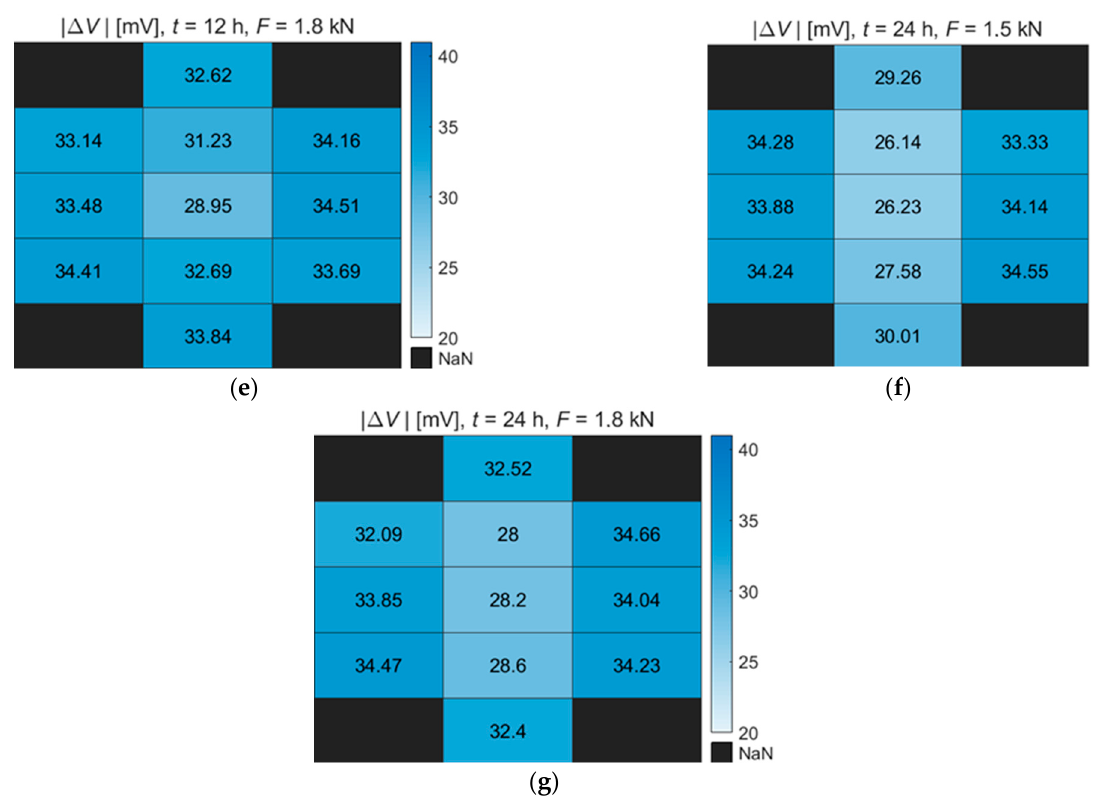
Figure 12. Map of the maximum value of the results, Specimen 1 ( a ), Specimen 2 ( b ), Specimen 3 ( c ), Specimen 4 ( d ), Specimen 5 ( e ), Specimen 6 ( f ), Specimen 7 ( g ), corrosion crack.